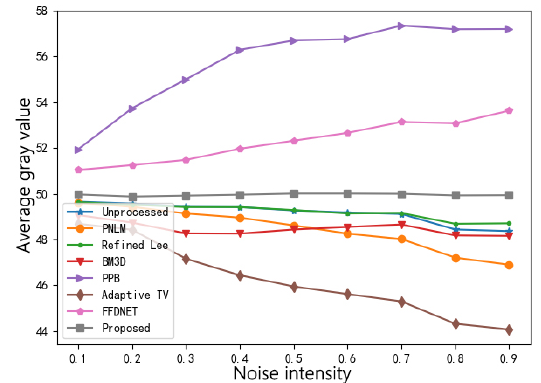
Figure 12. Comparison of gray restoration effect of various algorithms. Table 3. Data statistics o f nine gray pictures.